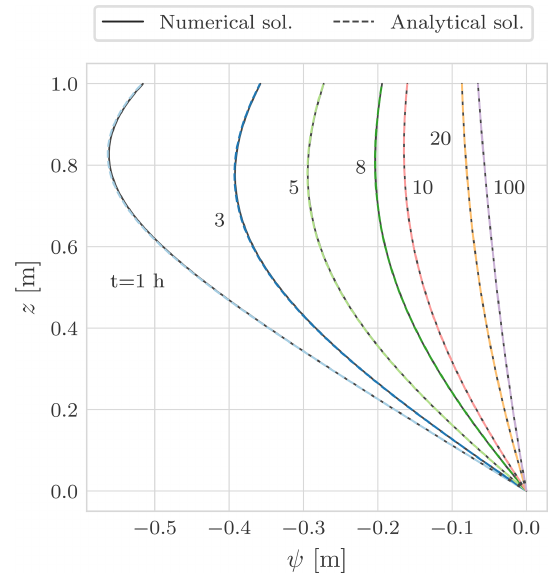
Figure C1. Comparison between the analytical and numerical solu- tions for the test problem TP1.